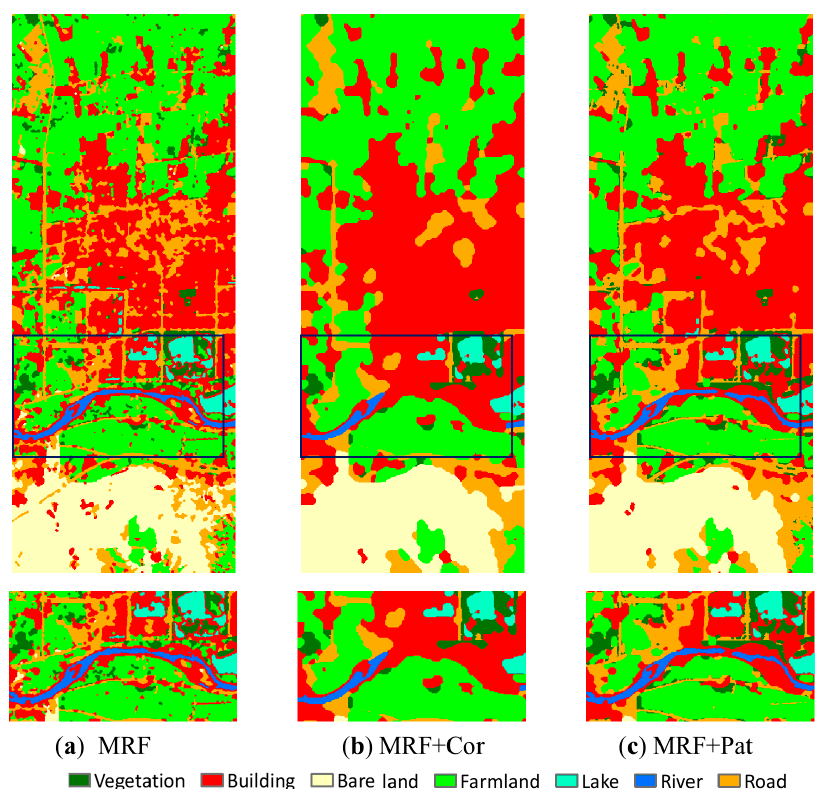
Figure 11. Contextual classification results based on the MLC for the Landsat image: ( a ) MRF result and zoomed image, ( b ) MRF + Cor and zoomed image, ( c ) MRF + Pat and zoomed image.